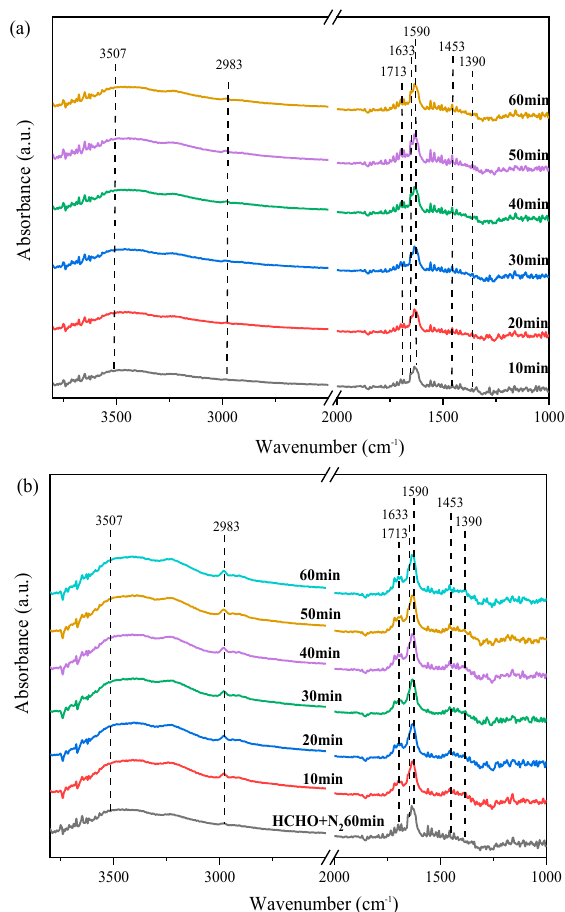
Figure 9. ( a ) In situ DRIFTS spectra of HCHO adsorption on the Eu/NaSep sample under the condition of 30 °C and 2000 ppm HCHO + N 2 (balance), and ( b ) in situ DRIFTS spectra of the Eu/NaSep sample in a flow of 2000 ppm HCHO + 20 vol % O 2 + N 2 (balance) at 30 °C and different time.